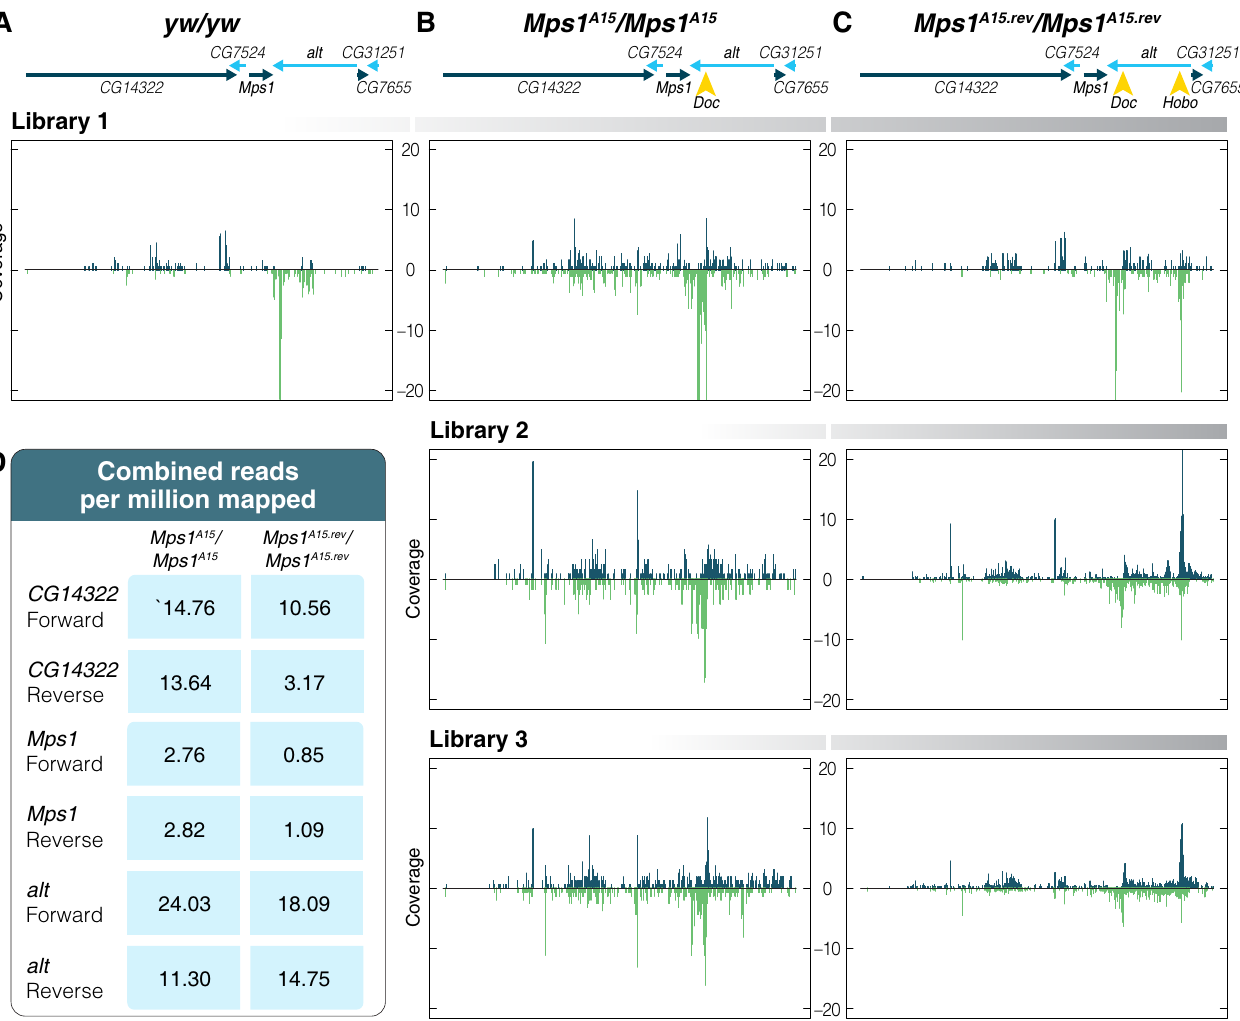
Fig 3. A Doc insertion within alt triggers the formation of genic piRNA biogenesis from both strands which is disrupted by a Hobo insertion. A) Small RNAs derived from convergently transcribed Mps1 and alt are single stranded and in the same direction of the genic transcripts. B) Results across multiple libraries indicate that the Doc insertion of the Mps1 A15 allele triggers dual-strand piRNA biogenesis across multiple genes. C) The Hobo insertion of the Mps1 A15 . rev allele disrupts Doc triggered dual-strand genic piRNA biogenesis. D) Quantification of mapped reads from combined libraries indicates piRNAs derived from both strands of Mps1 are reduced by approximately three-fold in Mps1 A15 . rev compared to Mps1 A15 but maintained at similar levels in both from alt .